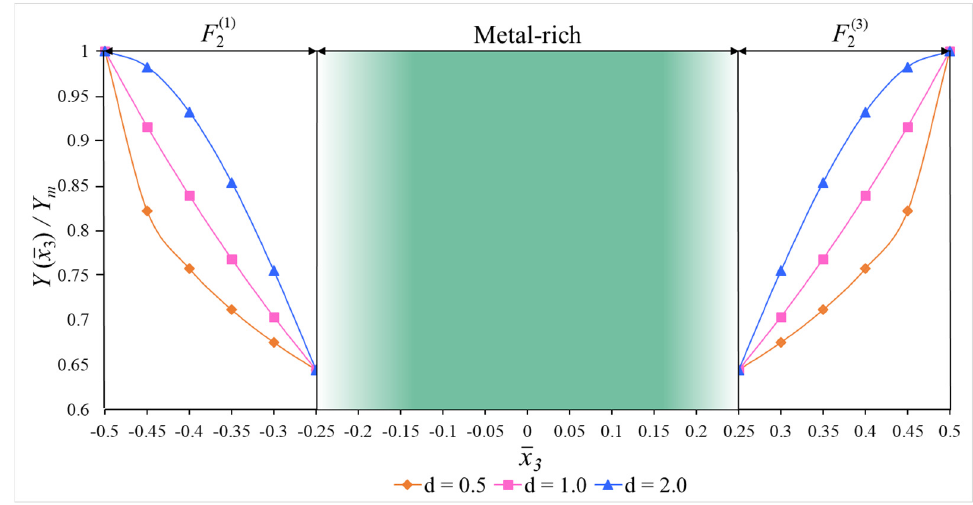
Figure 3. The variations in dimensionless Young moduli of the FG 2 /M/FG 2 cylindrical shells. The constitutive relationships of the elastic and isotropic layers of the FG-coated sandwich cylinders based on the FOST can be written as [11]: